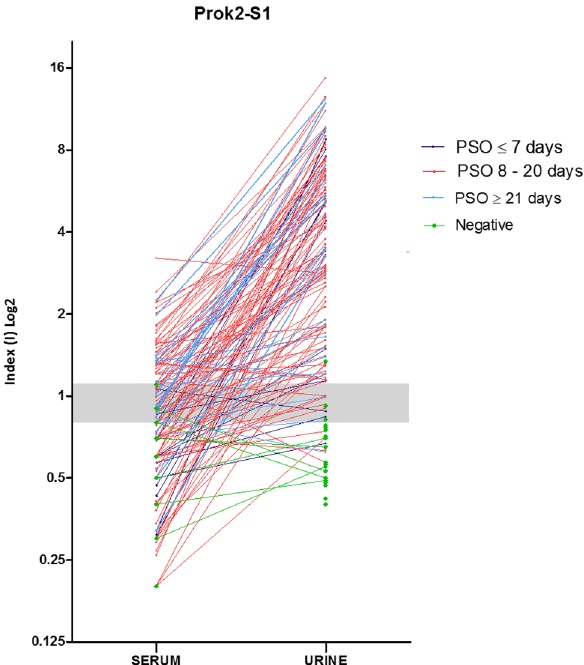
Figure 6. Evaluation of comparative urine and serum index values (I) of each patient according to the days post-symptoms onset (PSO) by using rSARS-CoV-2 Prok2-S1 protein. The index values obtained from urine and serum samples for each patient are represented by circles and when paired they are interconnected by lines, each color being specific to the collection period after the onset of symptoms Individual data were divided according to the PSO days of the collection date, i.e. at ≤ 7 days, 8 to 20 days and ≥ 21